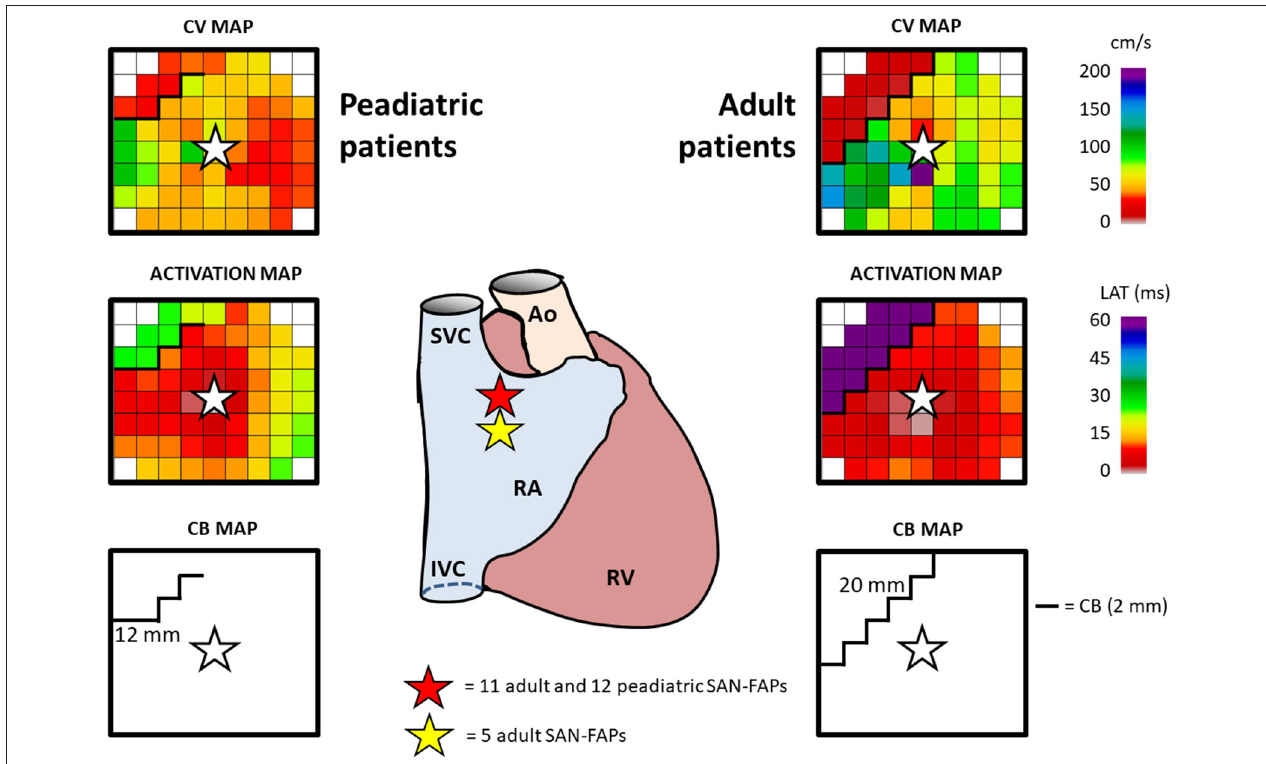
FIGURE 2 | Typical example of SAN activation. The center panel demonstrates the location of the SAN-FAPs in both an adult and pediatric patient. Characteristics of SAN activation in a pediatric (left) and adult (right) patient include CV (top), activation map (middle) and CB (bottom). The SAN-FAP origin is indicated by a white star. SVC, superior vena cava; IVC, inferior vena cava; RA, right atrium; RAA, right atrial appendage; RV, right ventricle; Ao, aorta; CV, conduction velocity; CB, conduction block; SAN-FAP, sino-atrial node—focal activation